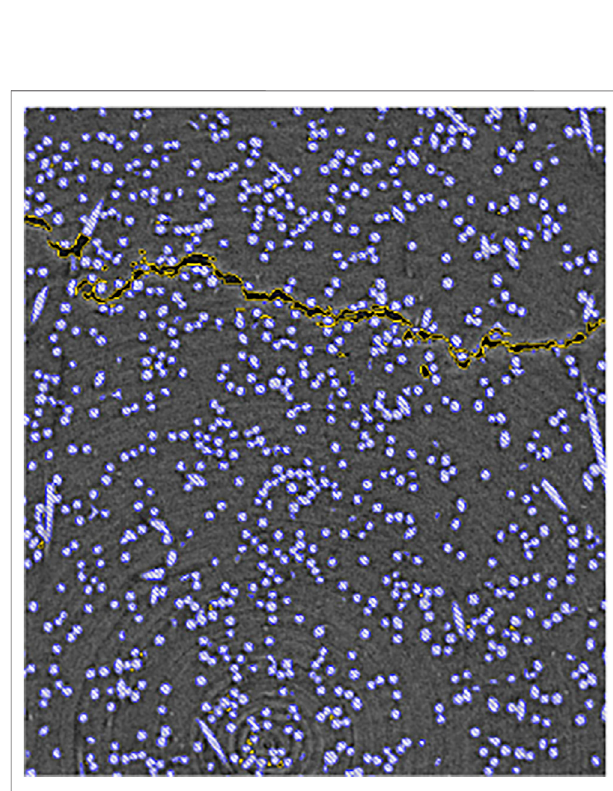
FIGURE 6 | Segmentation of the volume Crack. A crop from the vertical planeinaslicepassingthroughthefracture.The fi berphaseishatchedinblue and the porosity phase is contoured in